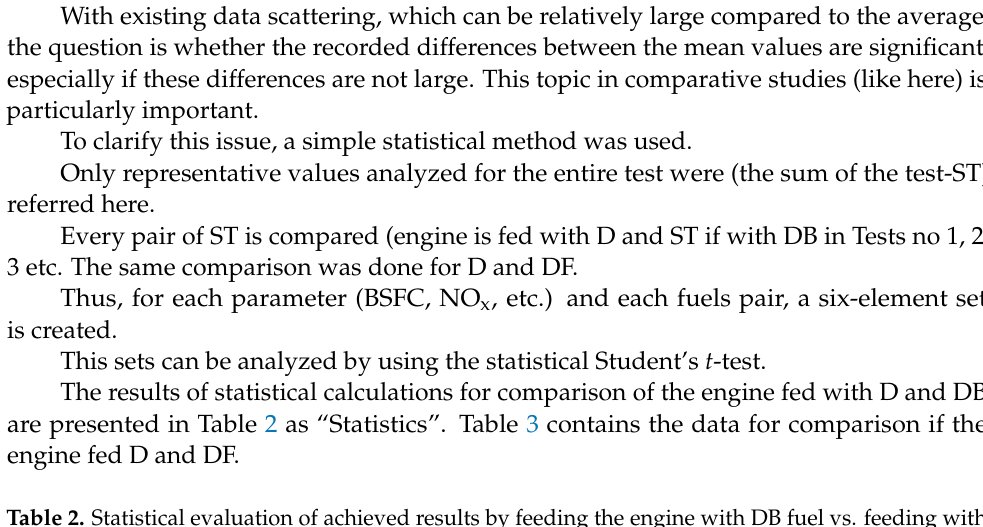
Table 2. Statistical evaluation of achieved results by feeding the engine with DB fuel vs. feeding with conventional